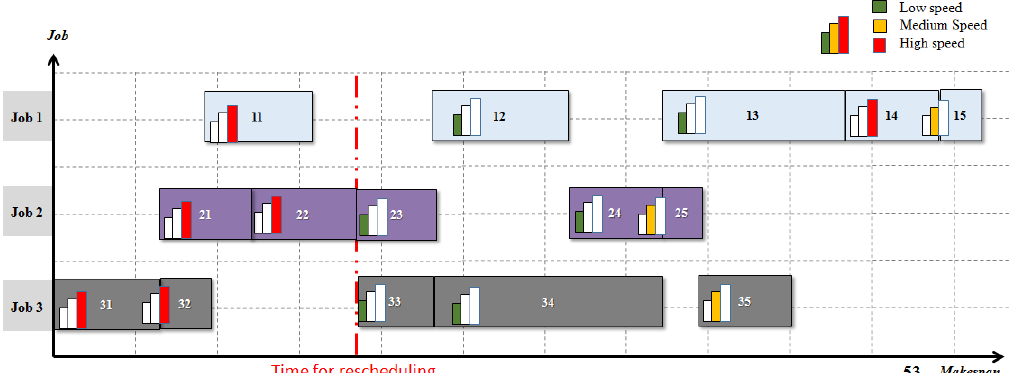
Figure 15. Profiling of the machine speed used in the reactive